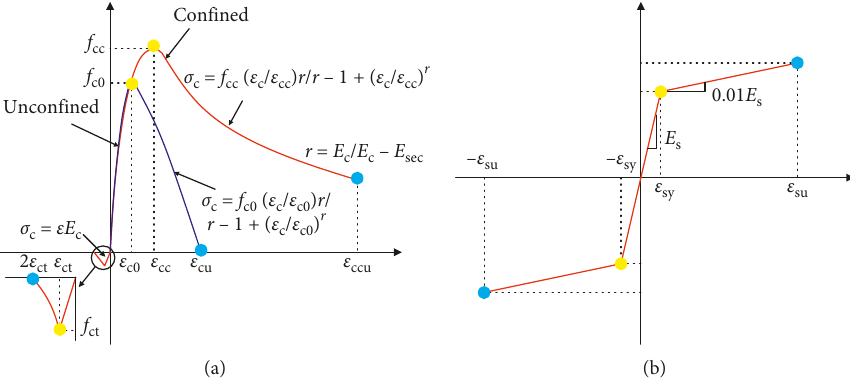
Figure 2: Material stress-strain relationships. (a) Concrete. (b) Reinforcing